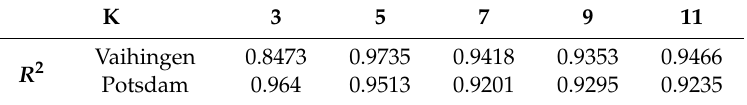
Table 4. Relationship between parameter K and the square of correlation coe ffi cient ( R 2